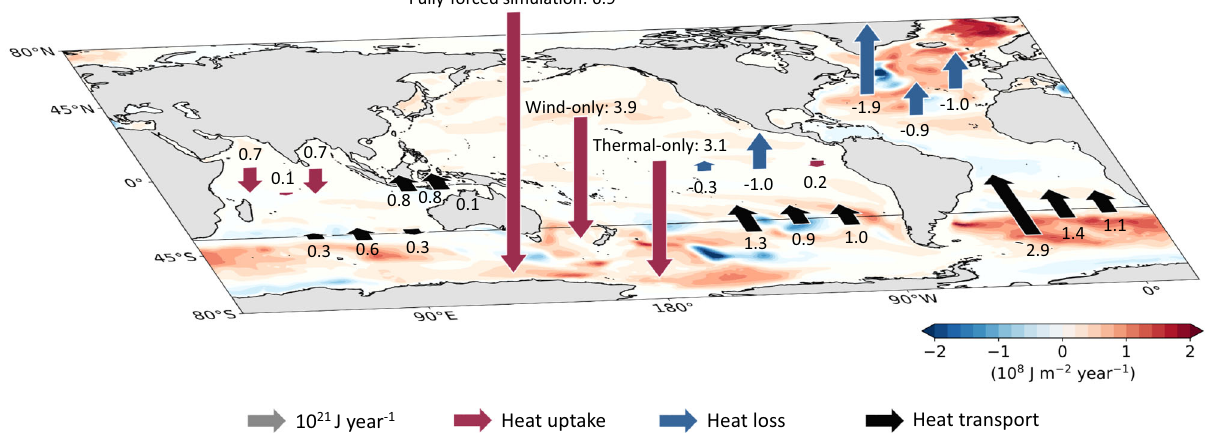
Fig.6|Schematicsummarisinganomalousglobaloceanheatuptake,heatloss and heat transport over the last half century in different historical simula- tions. The spatial pattern shows ocean heat storage rates in the full forcing simulation where all atmospheric forcing fi elds evolve over time (10 8 J m − 2 year − 1 ). The global ocean is divided into the Southern Ocean and the Indian, Paci fi c and Atlantic basins as in Fig. 3. The red and blue vertical arrows into and out of the plane show the basin integrated heat uptake and heat loss rates in the full forcing